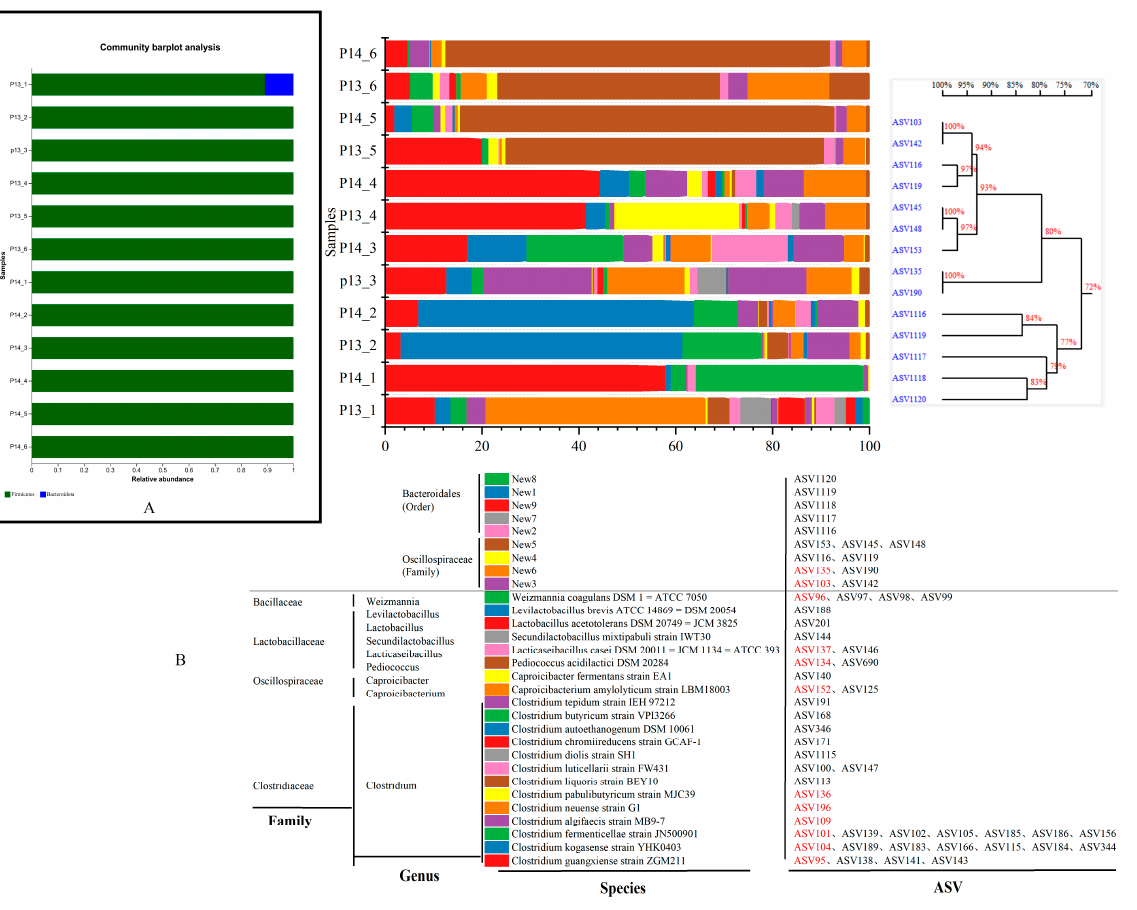
Figure 3. Distribution characteristics of bacterial community structures of samples in different enrichment rounds. ( A ) Percentage of community abundance at the phylum level. ( B ) Percentage of community abundance at the ASV level (the ASV was compared with the NCBI database, the species with a similarity of greater than 97% were grouped, and potential new species were classified and merged. Compared with the database, the similarity between ASV sequences is less than 97%, and the ASV sequences with similarity higher than 97% were classi fi ed as new species).